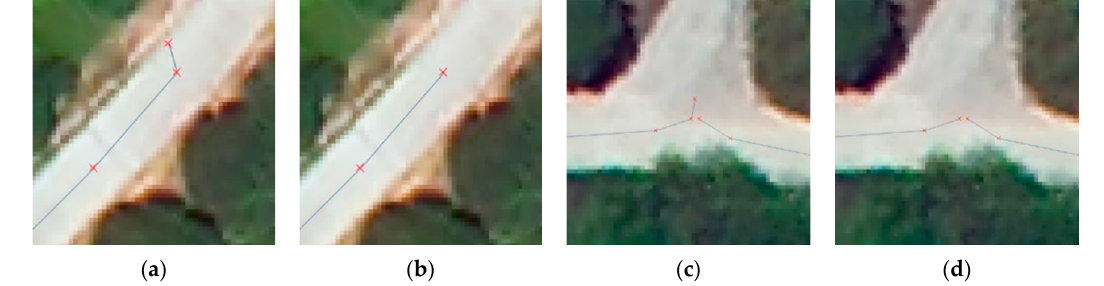
Figure 8. Optimizing segments: ( a , c ) show vectors with offset problems; ( b , d ) are the respective results of endpoint modification.